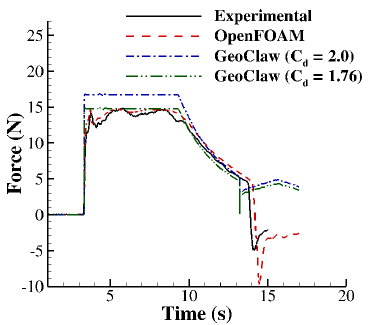
Figure 4. Comparison of measured and predicted horizontal forces on the square column. Sampling frequency is 300Hz in the experi- ment and 1000Hz in both numerical